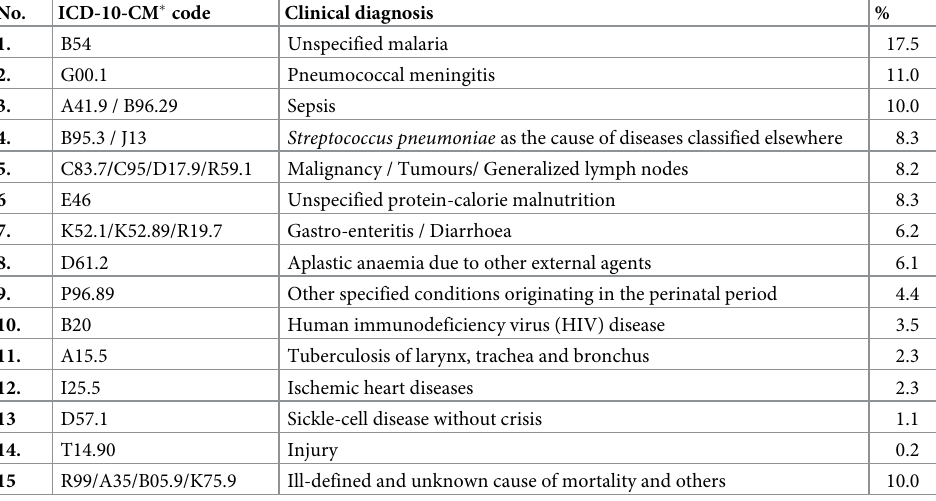
Table 2. List of ICD-10-CM codes collected for this study and percent of diagnostic CoD in children 1–59 months old in Yaounde´, 2006–2012.